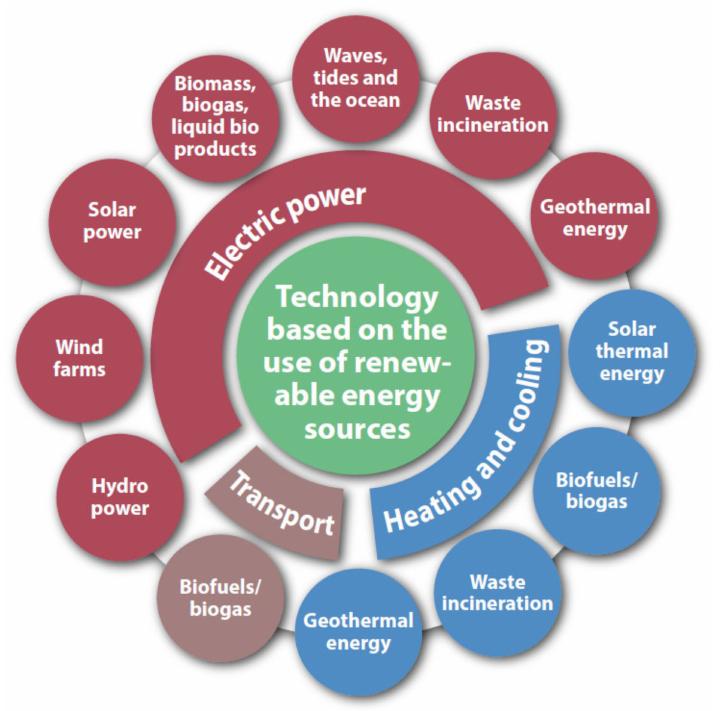
Figure 2. Technology based on the use of renewable energy